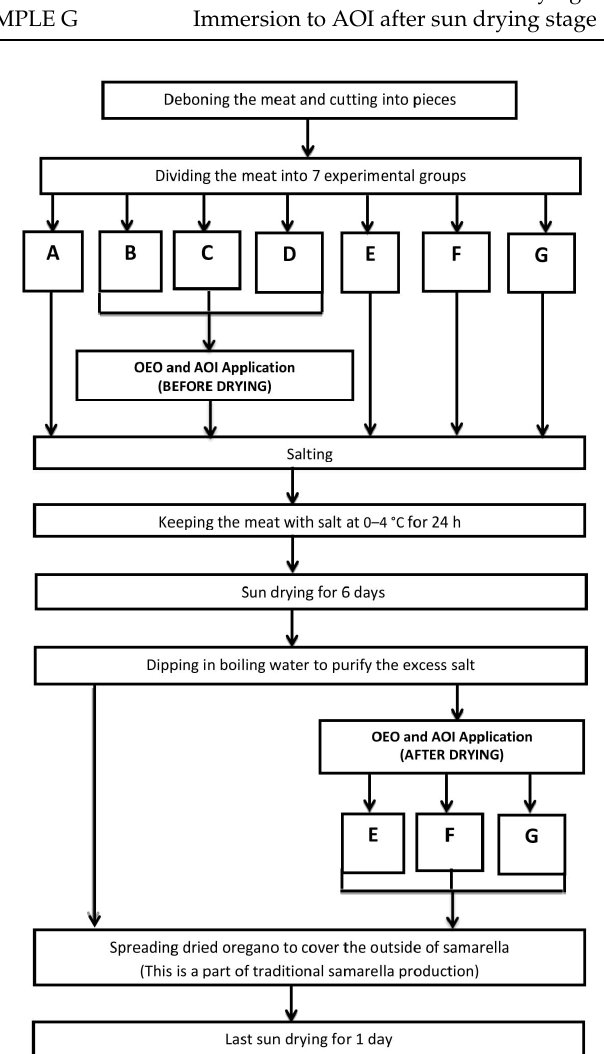
Figure 1. Production of samarella and experimental design. OEO: oregano essential oil; AOI: aqueous oregano infusion.